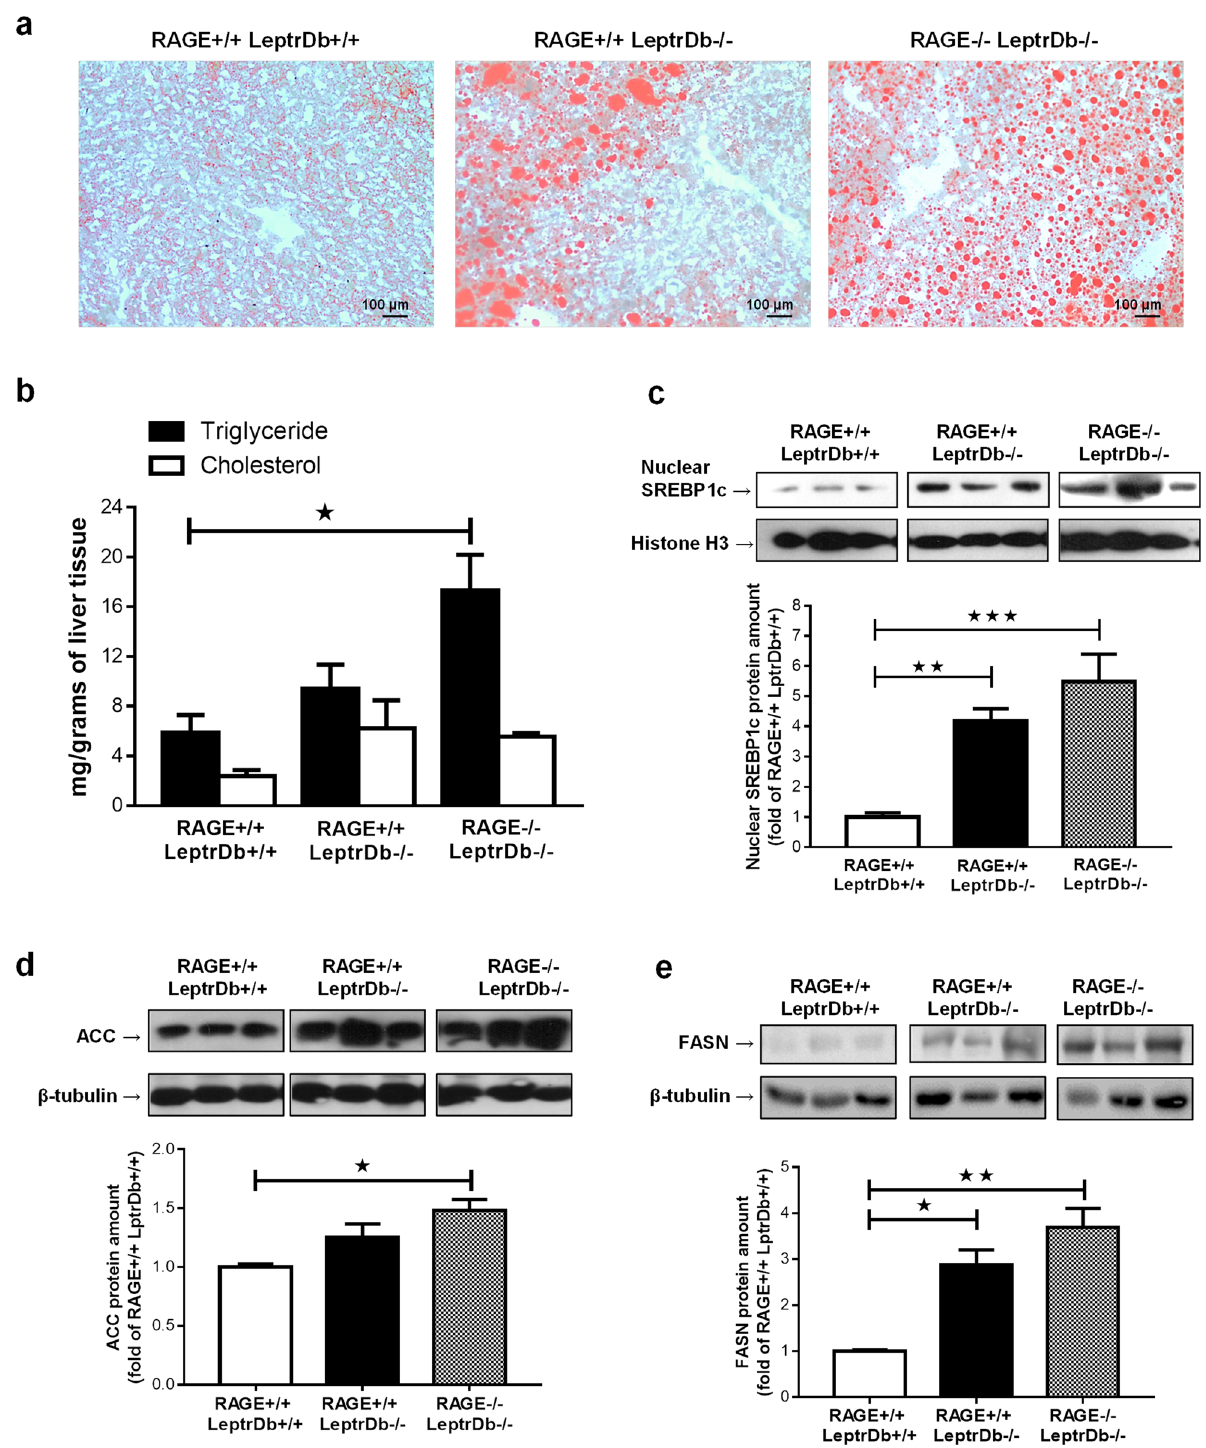
Figure 2. Hepatosteatosis. ( a ) Oil red O staining of 7 µm cryostatic sections of the liver from lean controls (RAGE+/+LeptrDb+/+), obese (RAGE+/+LeptrDb−/−), and RAGE KO obese (RAGE−/− LeptrDb−/−) mice showing hepatic lipids accumulation (20 × magnification). ( b ) Triglyceride and total cholesterol quantification in liver homogenates. ( c ) Western blotting analysis for the sterol regulatory element binding protein 1c (SREBP-1c) in nuclear extracts showing hepatic activation of lipogenesis. ( d,e ) Western blotting analysis for acetyl coenzyme A carboxylase (ACC) ( d ) and for fatty acids synthase (FASN) ( e) in liver extracts. Data are means ± SEM of 4–6 animals per group. Statistical significance: * P < 0.05; ** P < 0.01; *** P <